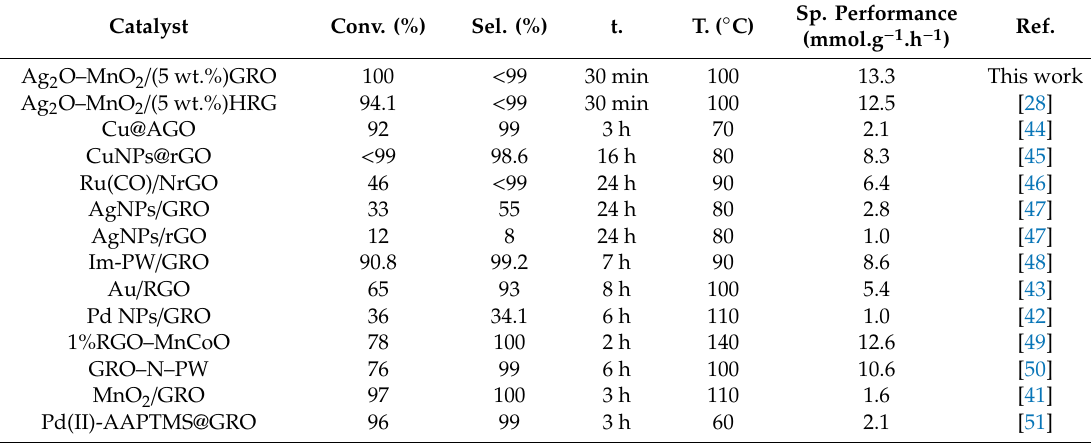
Table 3. Comparison of various graphene catalysts for selective oxidation of